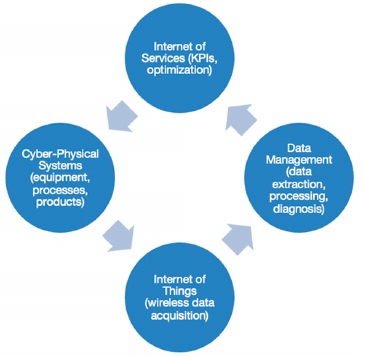
Figure 1. The structure for predictive maintenance in Industry 4.0.